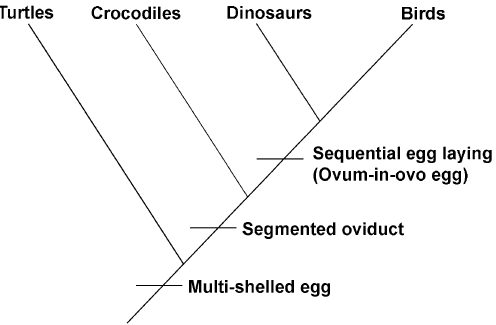
Figure 12. Inferred cladogram showing divergence of dinosaurs from crocodiles on the basis of sequential egg laying (figure drawn using software Adobe Photoshop